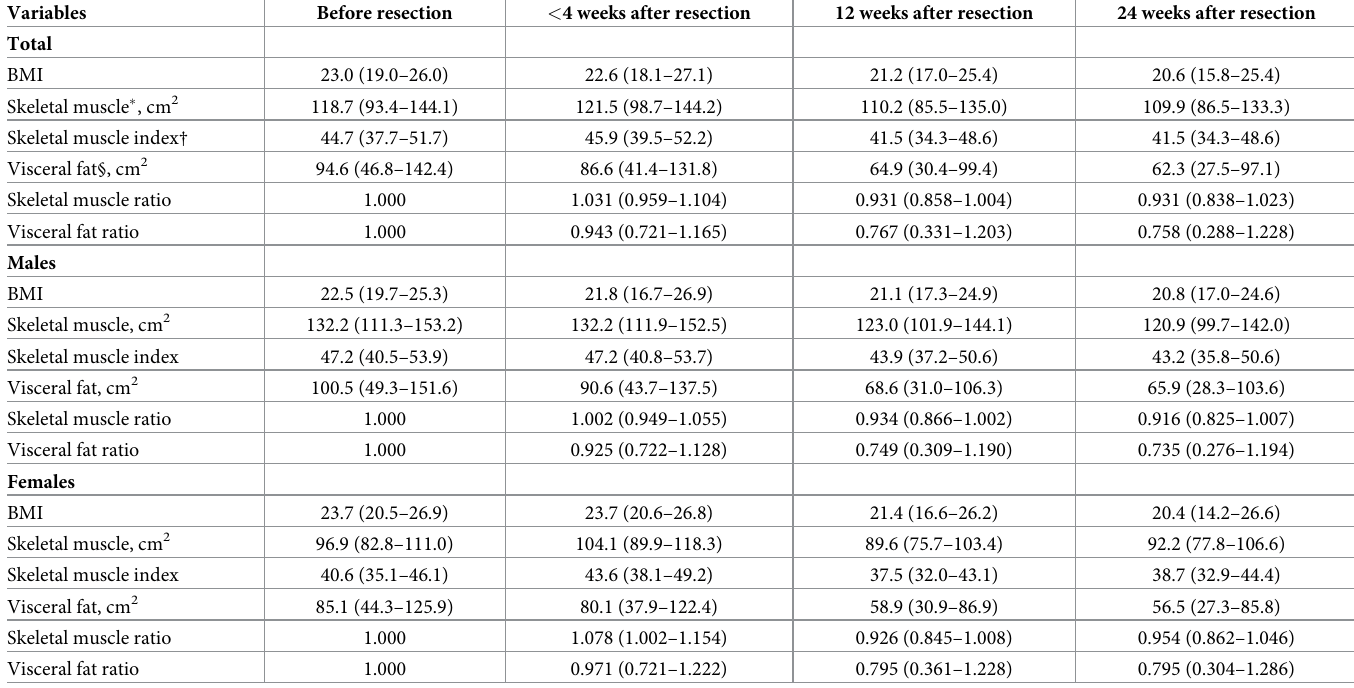
Table 2. Change in body composition parameters after resection of pancreatic cancer (mean, standard deviation). Variables